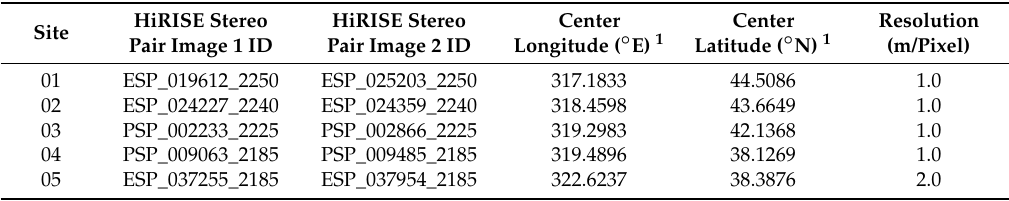
Table 1. List of DEMs derived from HiRISE image pairs at each